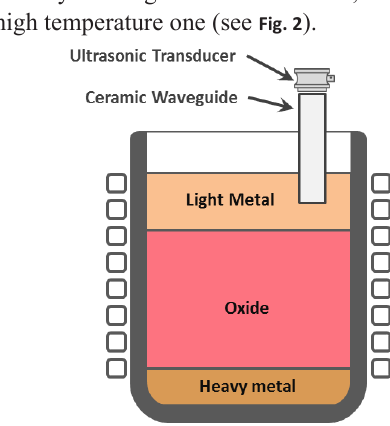
Fig. 4. Positioning by acoustic monitoring versus VITI